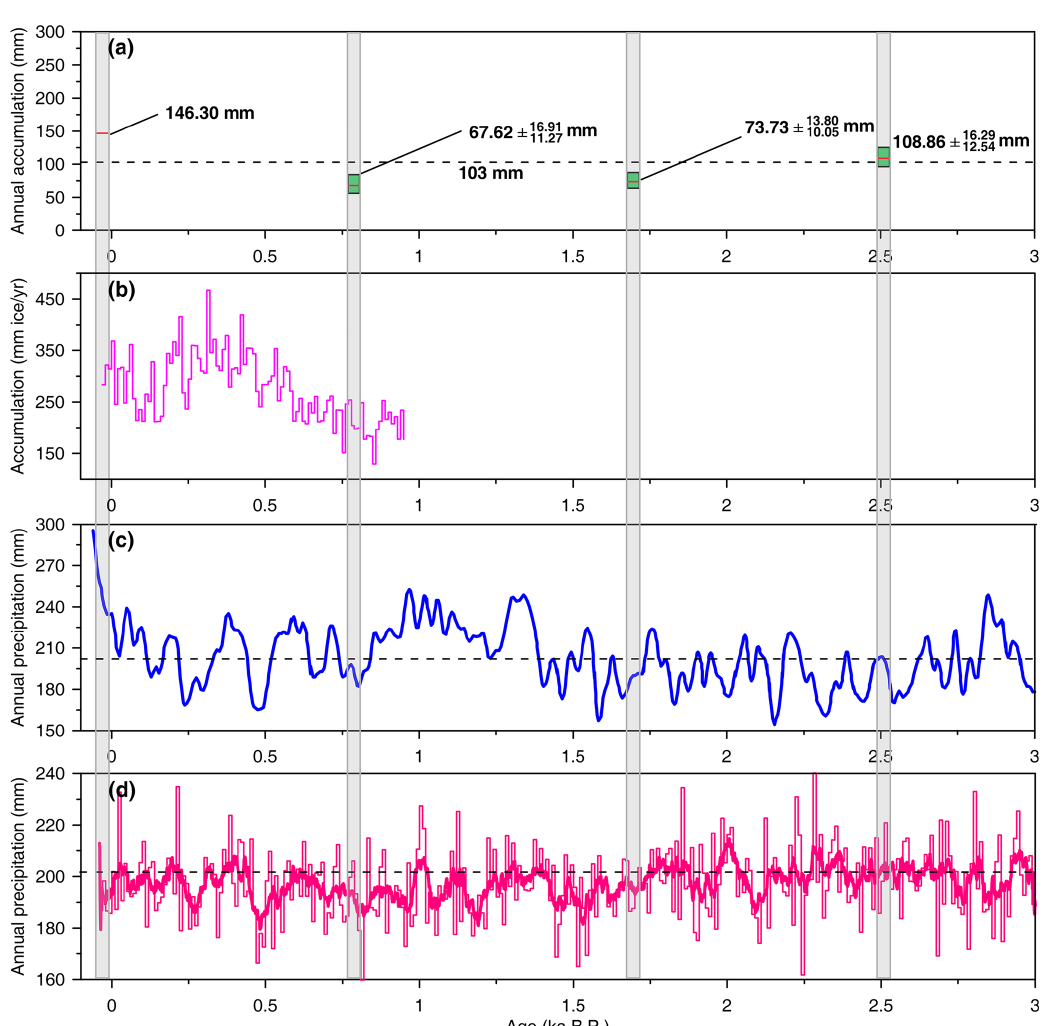
Figure 4. Our reconstructed annual accumulation for each of the four sections sampled (a) and its comparison with (b) snow accumulation reconstruction based on the Guliya ice core (Thompson et al., 2006), (c) precipitation reconstruction with 50-year smoothing in the northeast- ern TP (Yang et al., 2014), and (d) the TraCE-21ka model results for the region (34–36 ◦ N, 80–82 ◦ E) (Collins et al., 2006). The dotted lines in (a) and (d) represent the average annual accumulation over the Holocene. The dotted line in (c) represents average annual accumulation over the past 3.0ka. The thin and thick red lines in (d) represent the 10-year and 50-year moving average